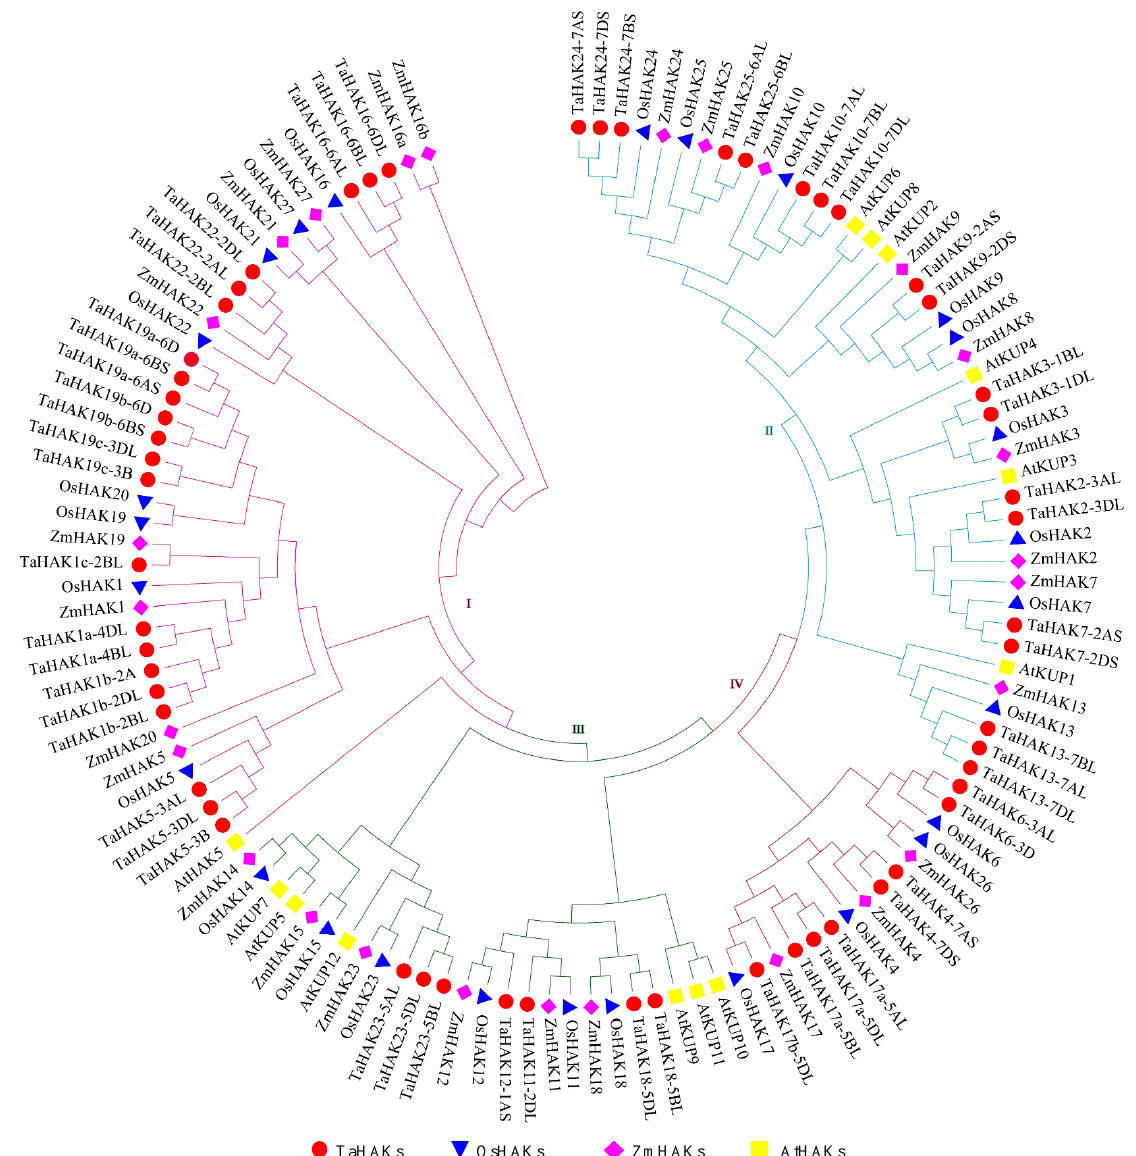
Figure 1. Phylogenetic tree of KUP/HAK/KT family proteins among wheat, rice, maize, and Arabidopsis. The proteins belonging to each of four species are represented by different shapes and colors. The KUP/HAK/KT family proteins were divided into four clusters (I, II, III, IV) and indicated with different colors of lines. The protein loci of rice, maize, and Arabidopsis KUP/HAK/KT family proteins are listed in Table S1. Ta, Triticum aestivum ; Os, Oryza sativa ; Zm, Zea mays ; At, Arabidopsis thaliana .